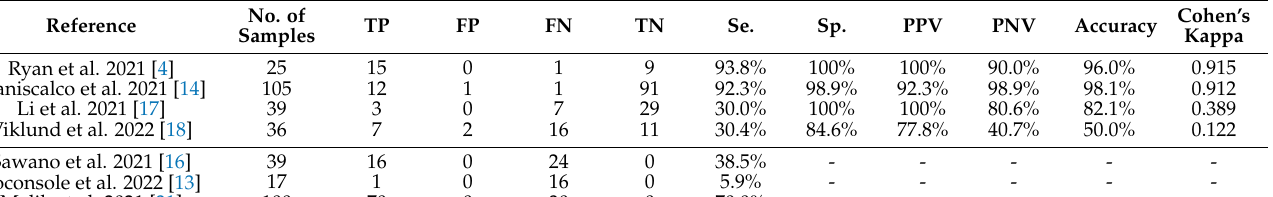
Table 3. A summary of the diagnostic performances of the studies included in the present meta- analysis (Notes: TP = true positive; FP = false positive; FN = false negative; TN = true negative;